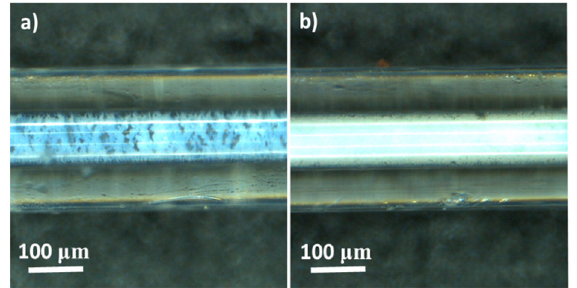
Figure 5. Microscope images of the different filled capillaries prepared in this study: ( a ) Cap. P25/F-127; ( b ) Cap. P25.